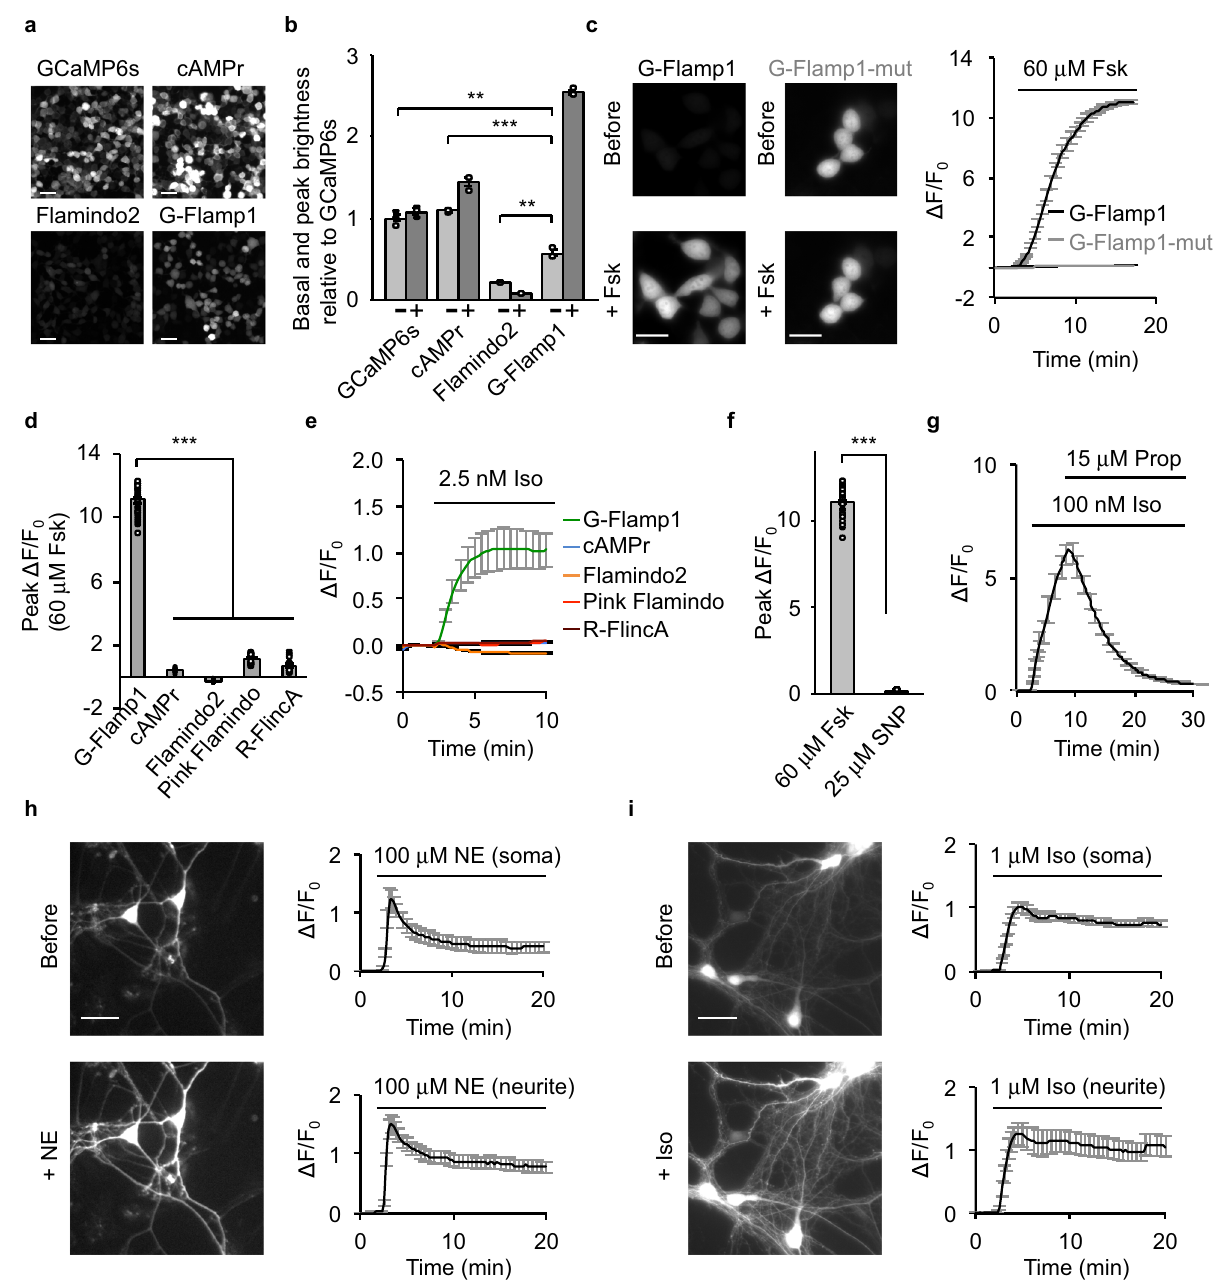
Fig. 2 | Characterization of G-Flamp1 in mammalian cells. a Representative fl uorescence images of the sensors in resting HEK293T cells from three indepen- dent experiments. Scale bars: 50 μ m. b Basaland peak brightness of the sensorsin HEK293T cells (excited at 488nm). n =3 cultures for each indicator. P =0.0033, 8.6×10 − 4 and 0.0069 between G-Flamp1 and GCaMP6s, cAMPr and Flamindo2, respectively. The minus and plus signs denote without and with 15min Forskolin (Fsk) treatment, respectively. c Representative fl uorescence images (left) and tra- ces of Δ F / F 0 (right) excited at 450nm in response to 60 μ M Fsk in HEK293T cells. n =34 (G-Flamp1) and 22 (G-Flamp1-mut) cells from 3 independent experiments. Scalebars:20 μ m. d Peak Δ F/F 0 inHEK293Tcells. n =34(G-Flamp1),33(cAMPr),42 (Flamindo2), 34 (Pink Flamindo) and 18 (R-FlincA) cells from 3 independent experiments. P =3.5× 10 − 38 , 2.8 × 10 − 38 , 1.4 × 10 − 41 , and1.6 × 10 − 46 between G-Flamp1 and cAMPr, Flamindo2, Pink Flamindoand R-FlincA,respectively. e Representative